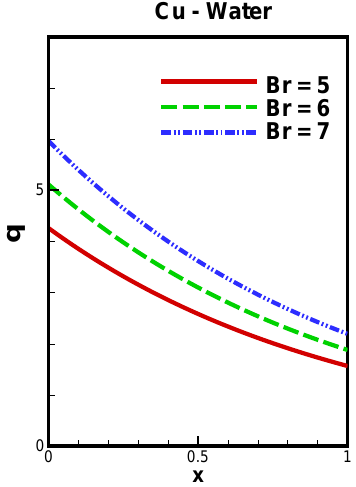
Figure 13. Effect of B r on dimensionless on dimensionless heat transfer, when φ = 0.05, R e = 1, δ = 0.2, β = 0.5, P e = 1, and γ =